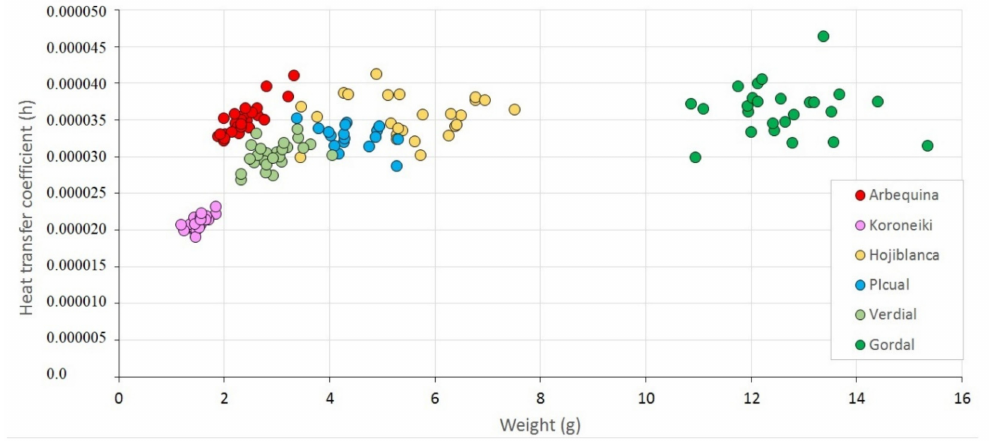
Figure 7. Correlation between the weight (g) and the convection heat transfer coefficient (h) of different olive cultivars ( n =